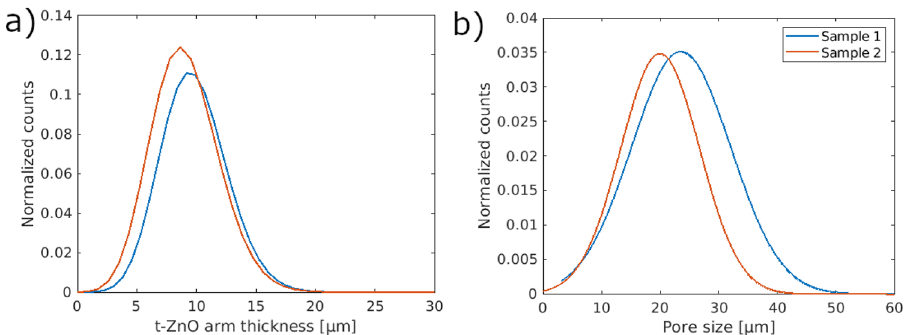
Figure 3. The t-ZnO arm thickness distributions in ( a ) show that sample 2 has slightly smaller thicknesses as sample 1. A similar trend is observed for the pore size distributions ( b ). Here, sample 2 indicates slightly smaller pores than sample 1.